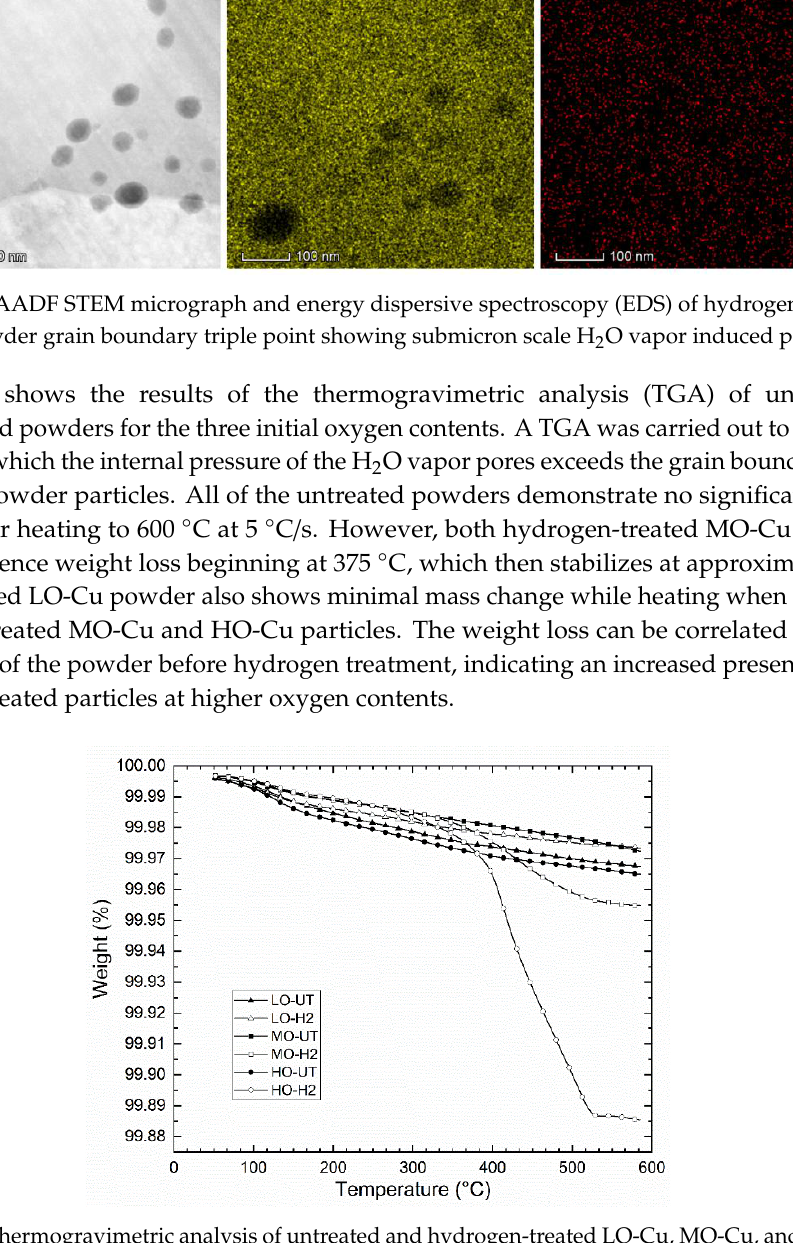
Figure 10. Thermogravimetric analysis of untreated and hydrogen-treated LO-Cu, MO-Cu, and HO- Cu powder under flowing nitrogen.